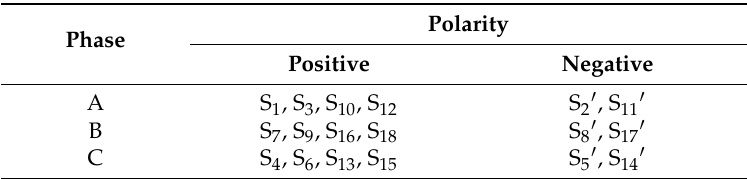
Figure 5. General electrical equivalent circuit. Figure 6 shows the flux flow from the N pole PM through the outer air gap into the stator yoke teeth and travels along the stator yoke and also along the stator core. Then the flux flow through adjacent stator yoke to outer air gap and through rotor core the S pole of PM to the inner stator air gap then return to adjacent slot through the inner stator core and yoke. Then, the flux flows to the inner air gap and rotor core. Figure 6. Flux flow of three phase DSSR-PMG.